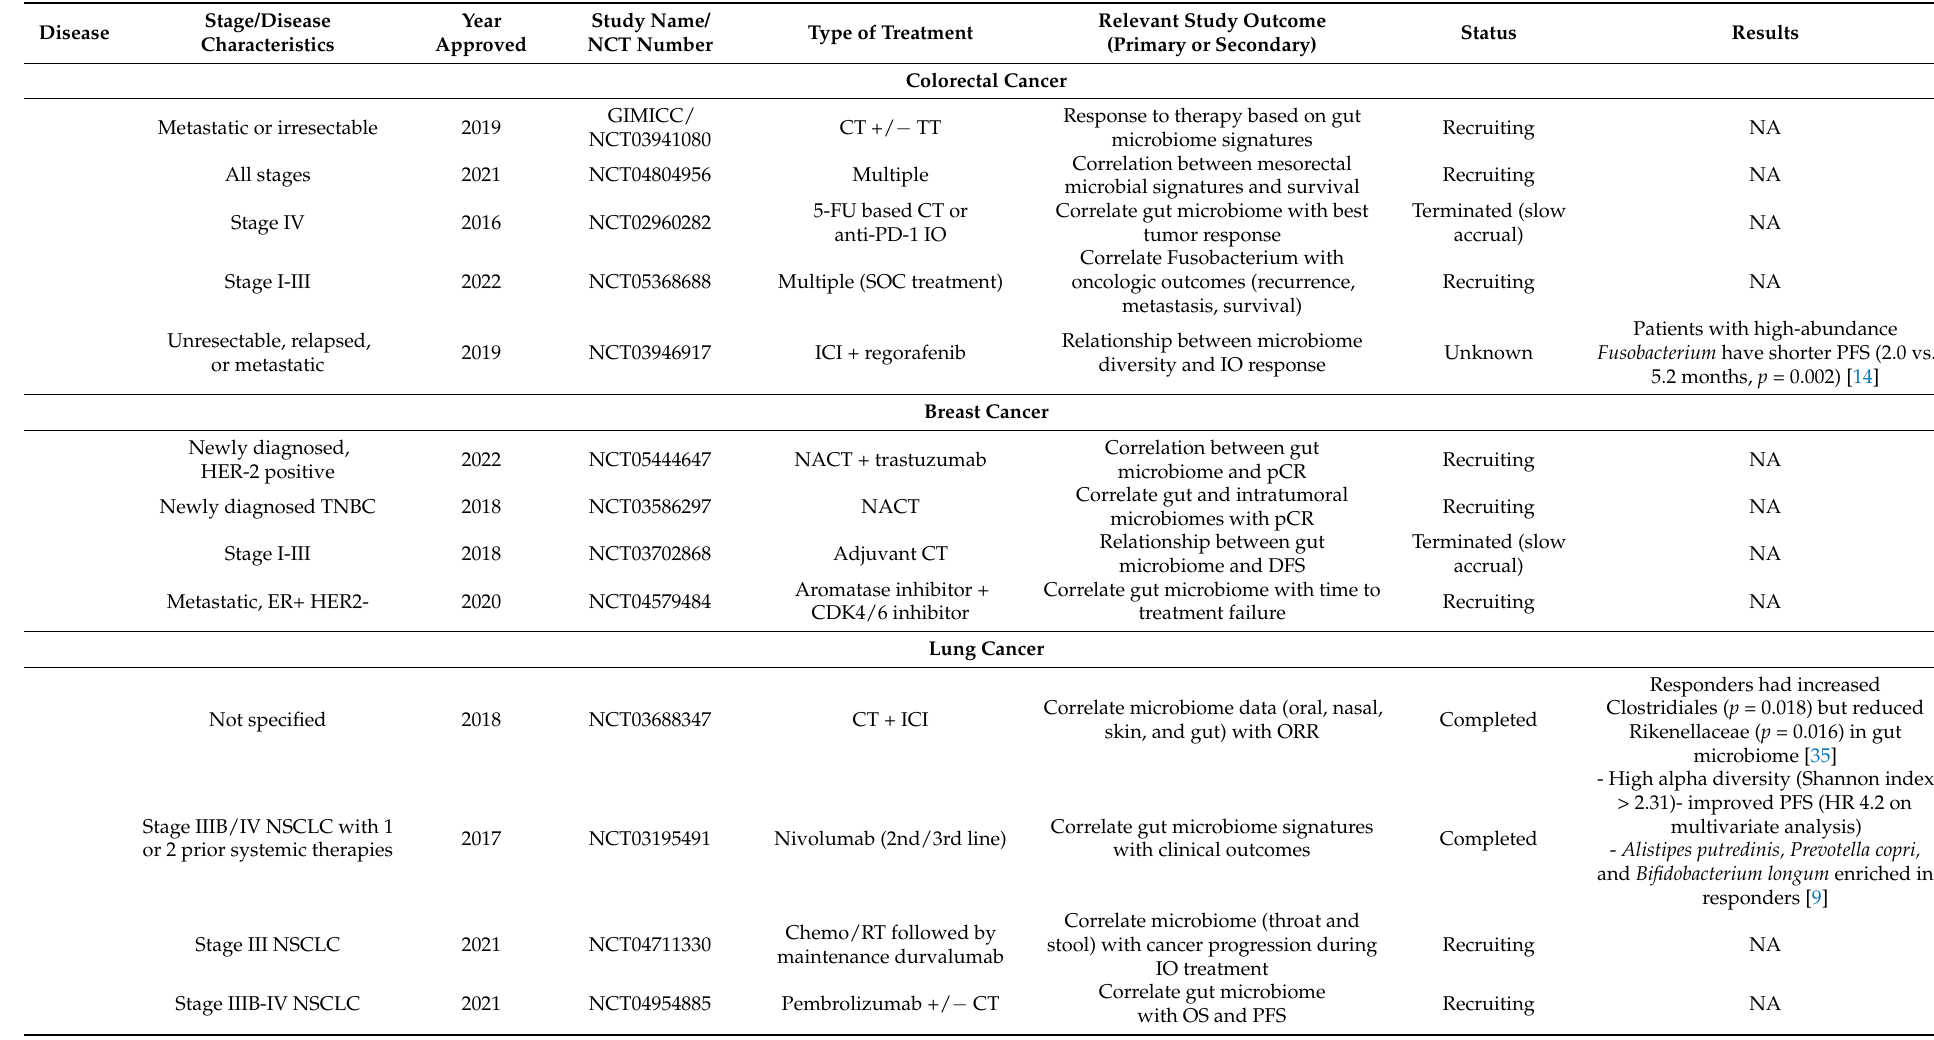
Table 1. Trials examining the gut microbiome and the response to cancer